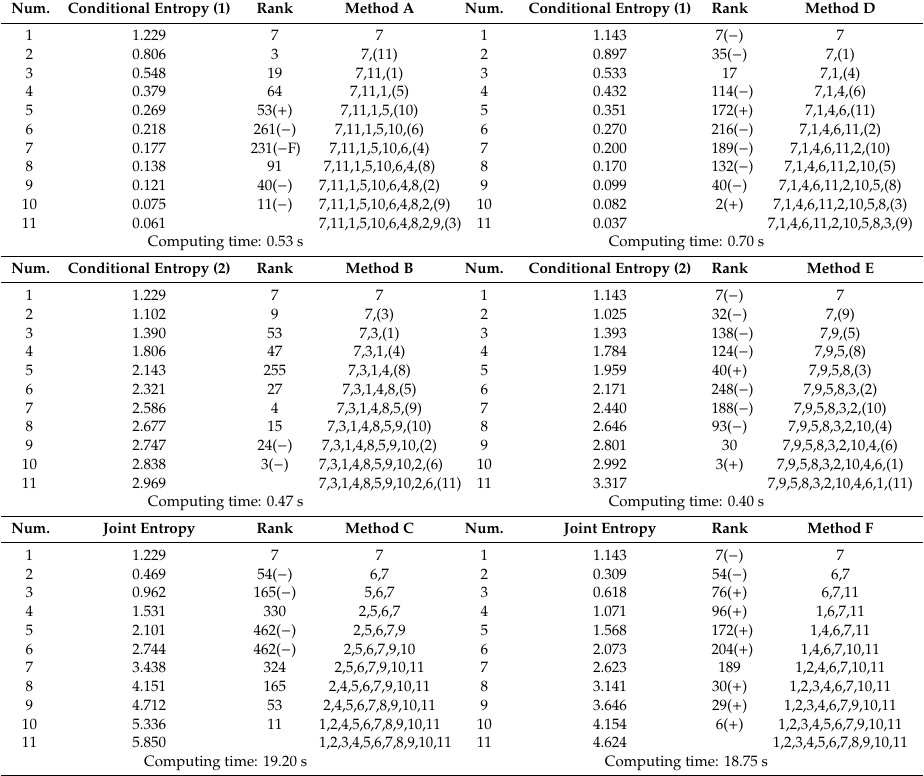
Table A5. Results of a select optimal rain gauge network of methods (weight: precipitation by station). Num. Conditional Entropy